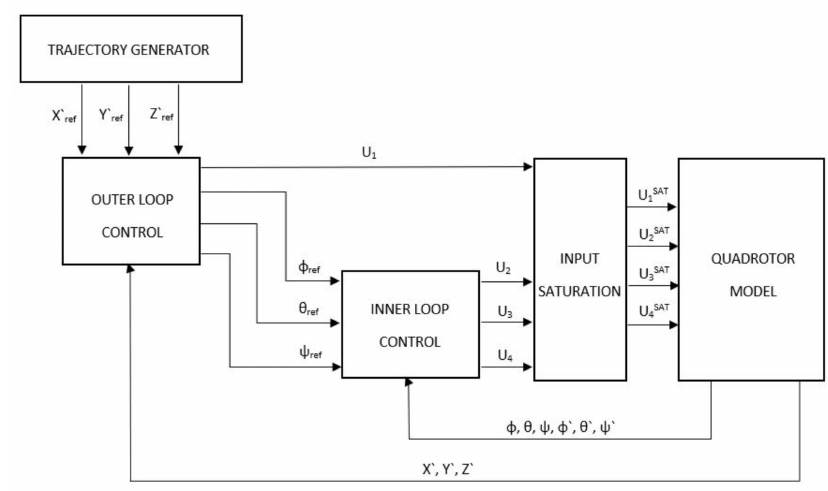
Figure 3. Overview of the proposed control system’s